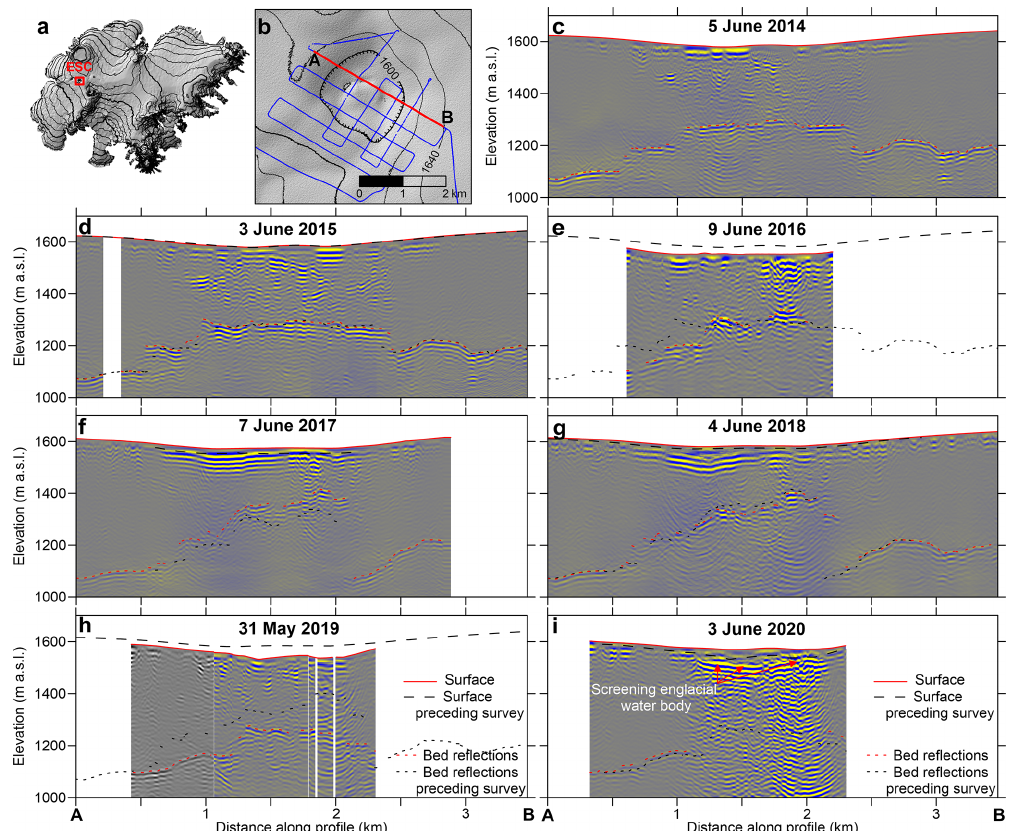
Figure 2. (b) The initial RES survey route of the ESC (location in panel a ) in 2014. The DEM presented with shaded relief and contour map (20m interval) was obtained from TanDEM-X data acquired on 23 September 2015. (c–i) An example of 2D migrated RES profiles for part of this route (from A to B on b ) for all survey years. The vertical exaggeration is 2-fold. On each profile, the traced bed reflection (both from ice–bedrock and ice–water interface) and surface elevation are shown along with same information from the survey in the preceding